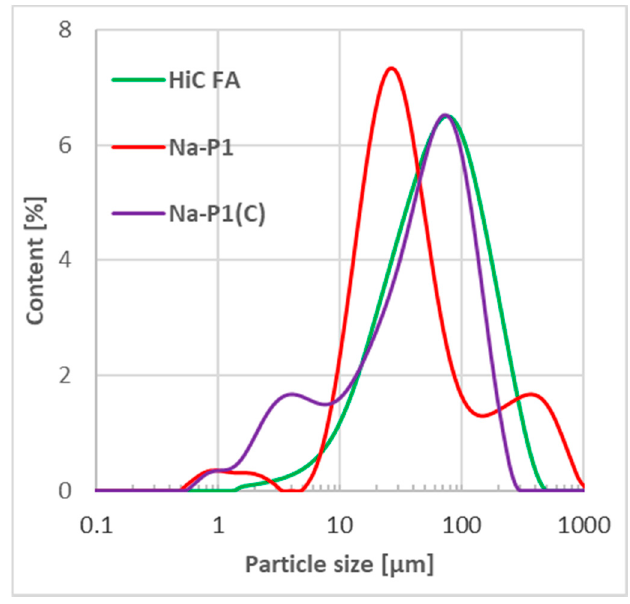
Figure 1. Particle size distribution of HiC FA, Na ‐ P1 and Na ‐ P1(C).